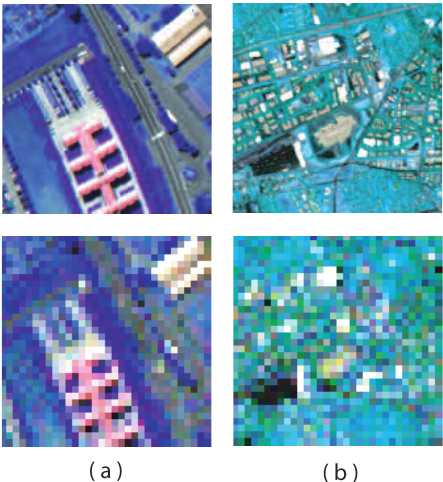
Figure 5. Display of (top row) the reference images and (bottom row) observed hyperspectral images (HSIs) for the two datasets; i.e., ( a ) Pavia University and ( b )